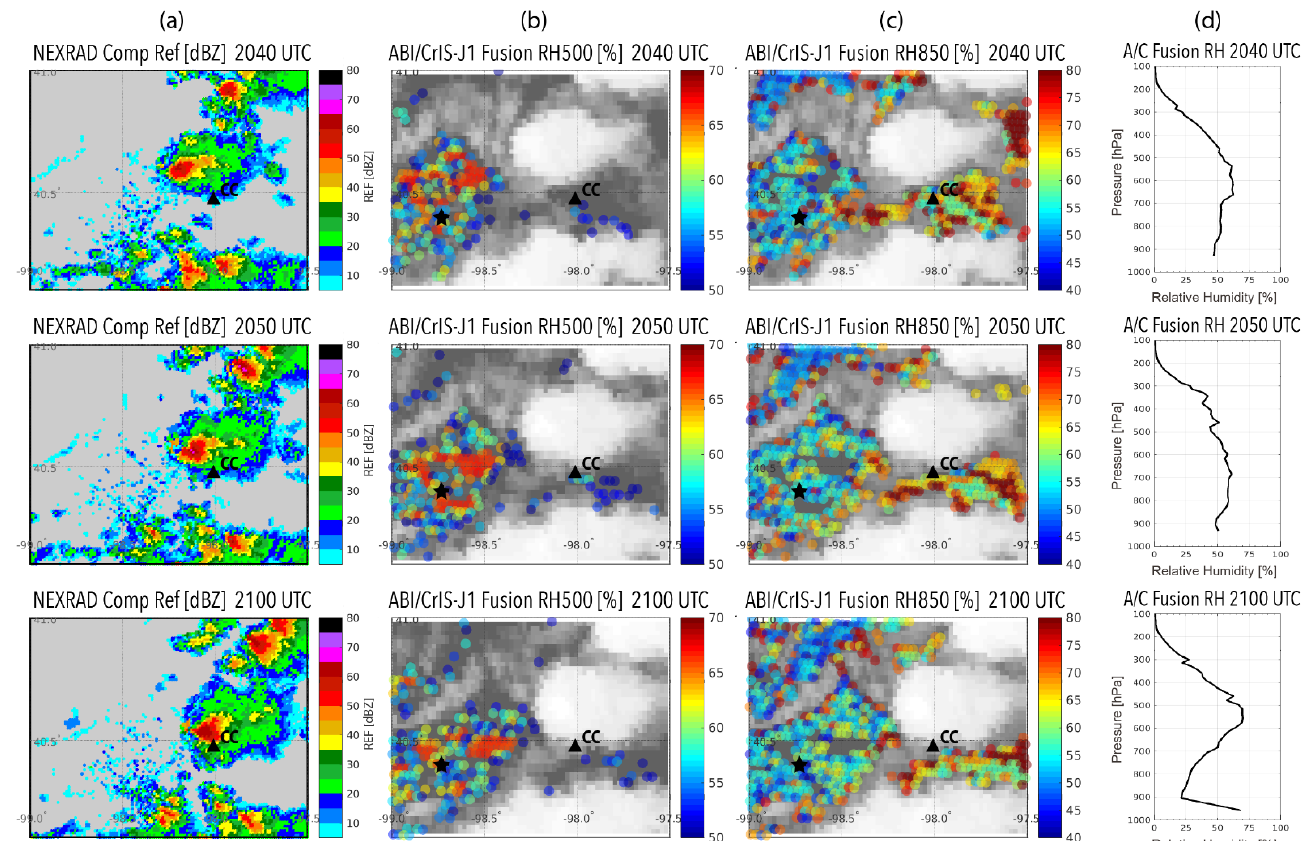
Figure 8. ( a ) Regional NEXRAD composite reflectivity; ( b ) ABI/CrIS fusion RH [%] at 500 hPa; ( c ) ABI/CrIS fusion RH [%] at 850 hPa; and ( d ) ABI/CrIS fusion RH profiles for the location marked by a black asterisk in panels ( b , c ), about 60 km west of Clay Center (CC) at 2040 UTC ( top row), 2050 UTC ( middle row), and 2100 UTC ( bottom row) on 5 May 2021. Note the different color scale for panels ( b , c ).